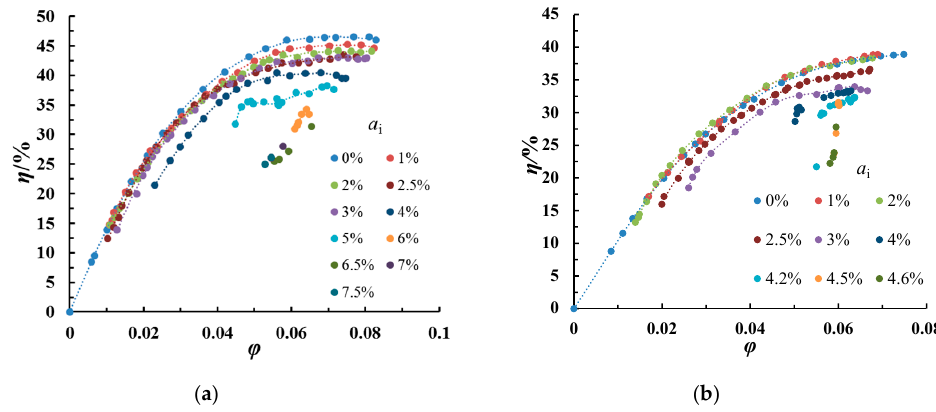
Figure 4. Pump efficiency for two rotational speed: ( a ) n = 1450 r/min and ( b ) n = 1000 r/min. Theoretical head coefficients ψ th are given in Figure 5 for both rotational speeds. Both images show the same theoretical head coefficient change for one-phase flow conditions (only water).